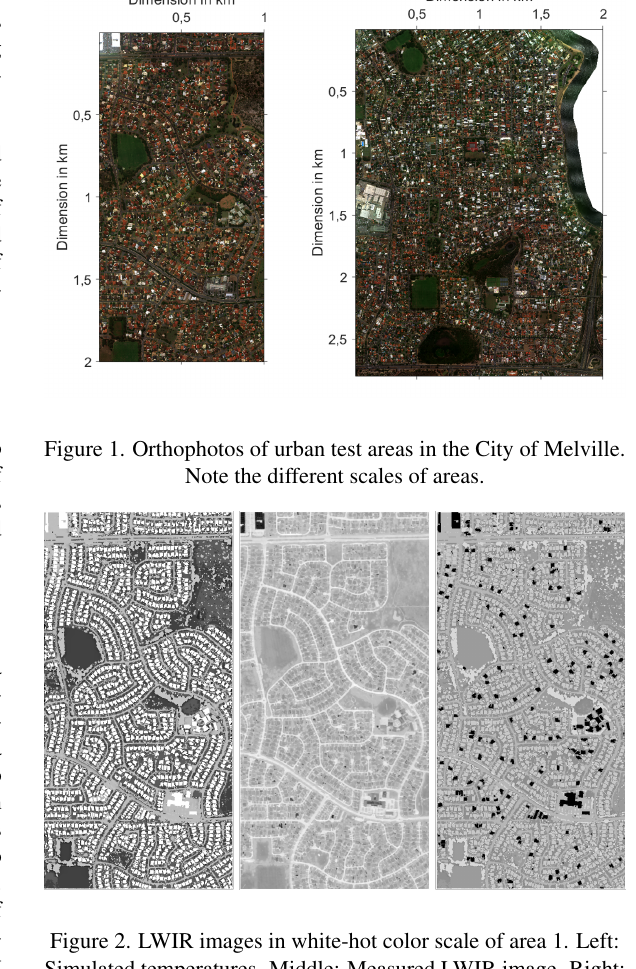
Figure 2. LWIR images in white-hot color scale of area 1. Left: Simulated temperatures. Middle: Measured LWIR image. Right: Simulated LWIR image.